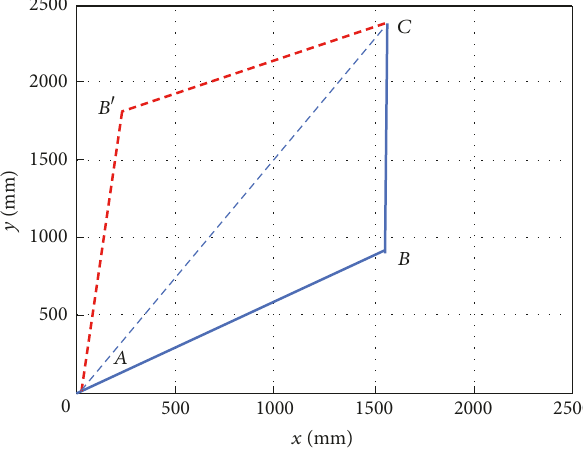
Figure 7: Different configurations for inverse position.